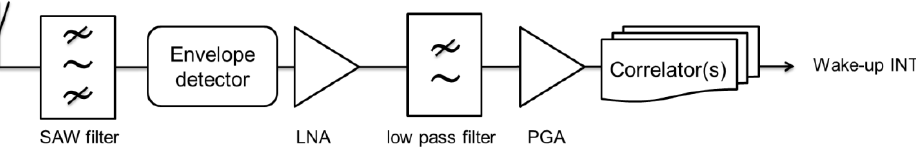
Figure 20. Block diagram of the correlator-based WuRx in